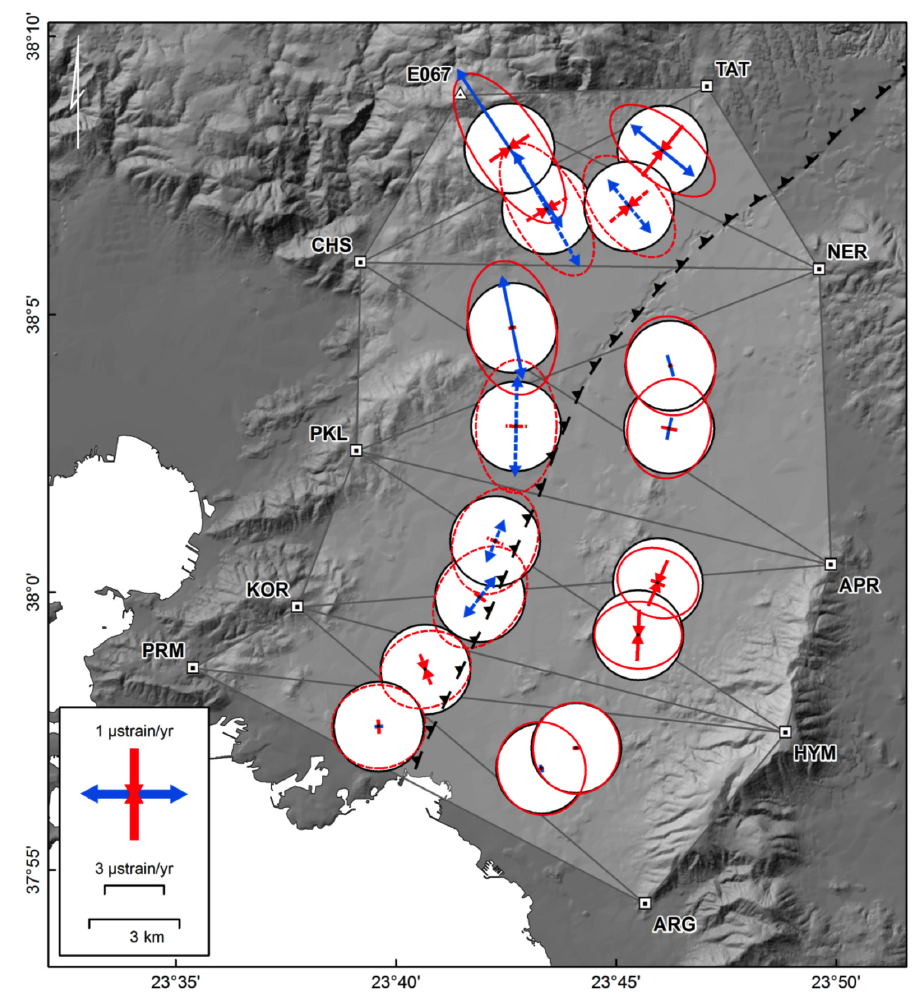
Figure 6. Detailed strain analysis by different triangulations of selected GPS sites. Principle axes of the strain rate tensors are calculated at the center of mass of each triangle. The approximate location of the tectonic boundary separating metamorphic and non-metamorphic alpine rocks in Attica is shown (dashed line). There is a significant strain-rate difference on either side of the